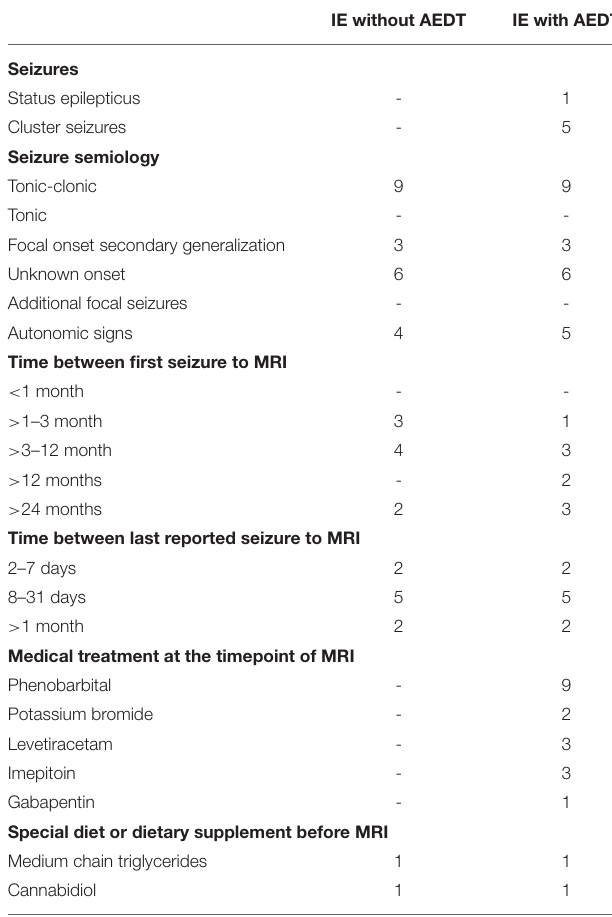
TABLE 1 | Population characteristics. TABLE 2 | Semiology of epileptic events in the affected